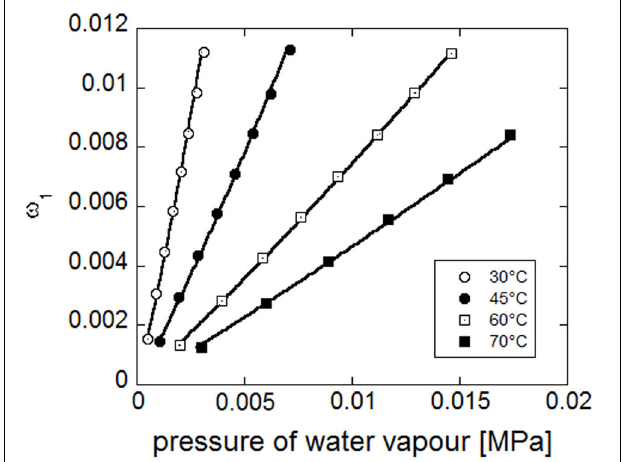
FIGURE 14 | Fitting of experimental water sorption isotherms for PEI, reported as water mass fraction in the amorphous phase vs. pressure of water vapor. Continuous lines represent fitting curves provided by NETGP-NRHB